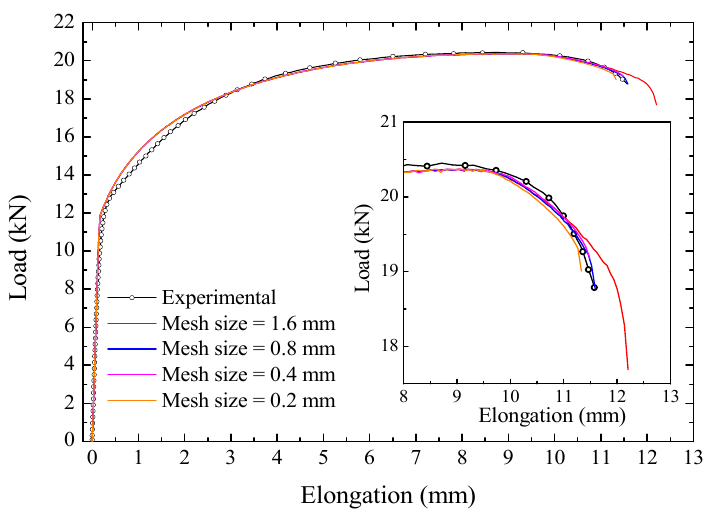
( d ) Figure 19. Different mesh sizes in the gauge length region of the uniaxial tensile specimen: ( a ) 1.6 mm, ( b ) 0.8 mm, ( c ) 0.4 mm, and ( d ) 0.2 mm. Figure 20 compares the force-elongation prediction determined with different mesh sizes with the experimental data to the rolling direction. The four mesh sizes provided the